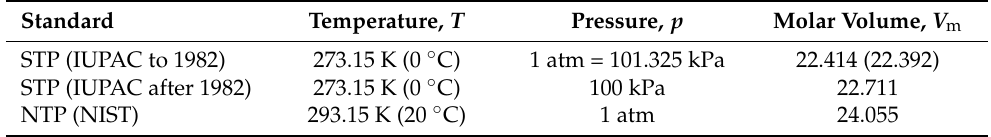
Table 2. Ideal-gas molar volumes (L/mol) for STP and NTP temperature and pressure definitions. Bracketed value in first row is the actual (non-ideal) molar volume for O 2 at STP (pre-1982). Standard